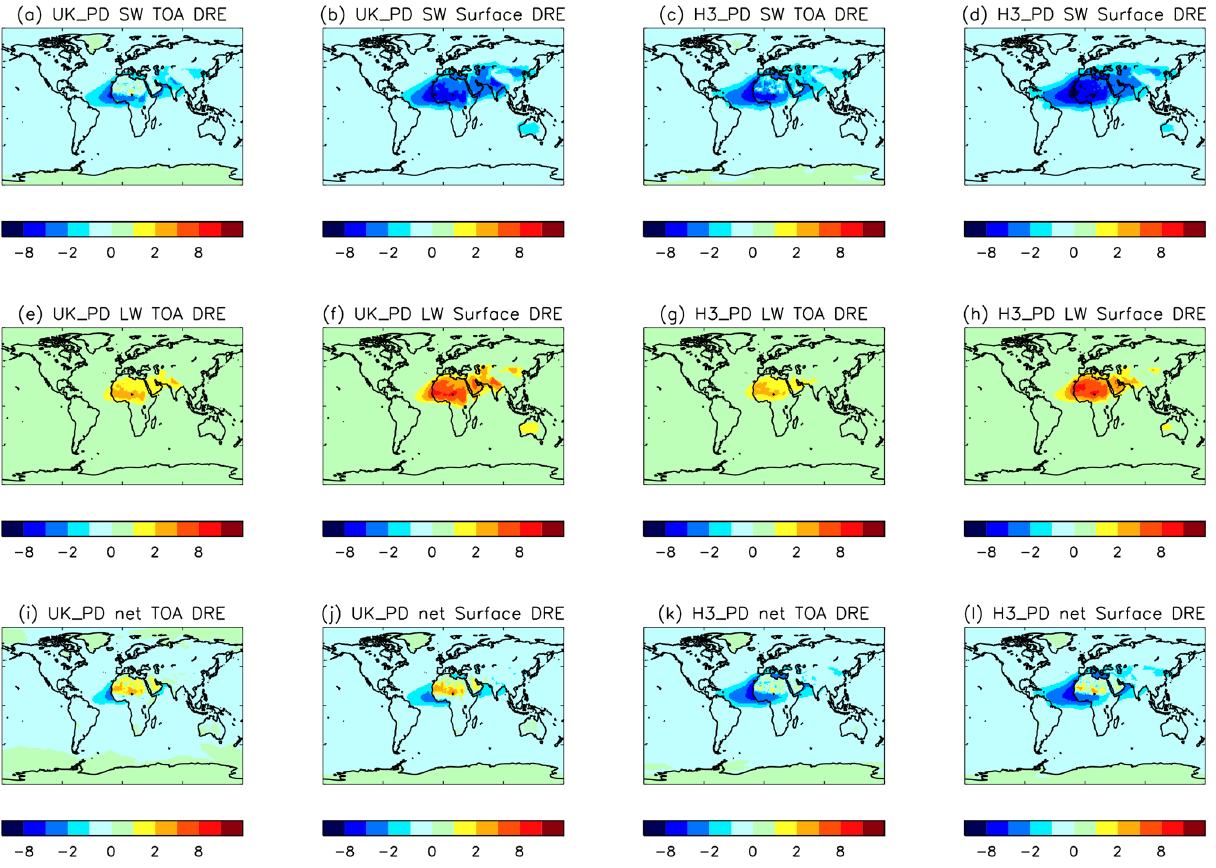
Figure 7. Dust direct radiative effects (Wm − 2 ) in UK_PD and H3_PD.